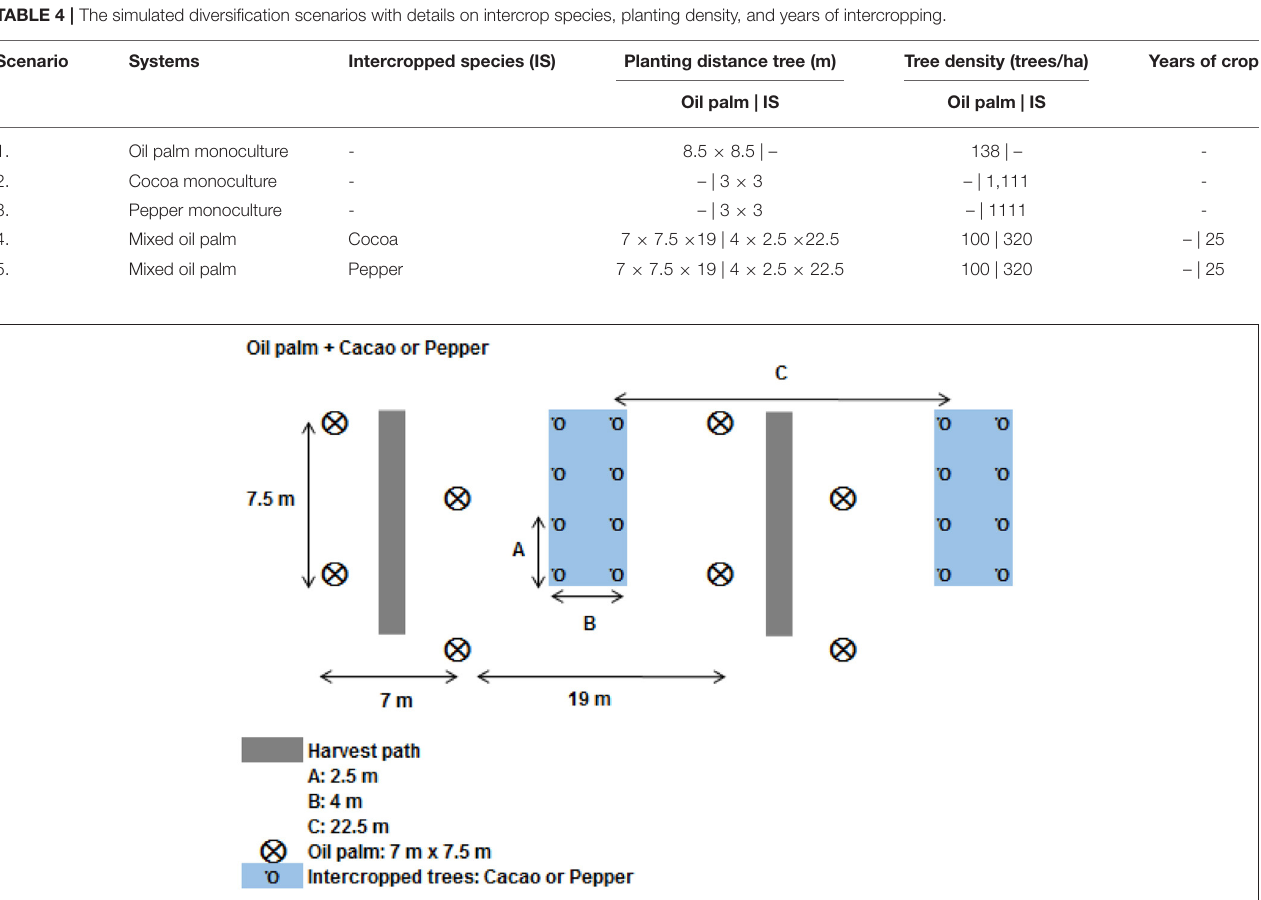
FIGURE 3 | Design and spacing of intercropping oil palm with Cocoa or Pepper in a double row arrangement adapted from the system developed by Embrapa in Brazil for cocoa and the Malaysian Oil Palm Board for pepper.